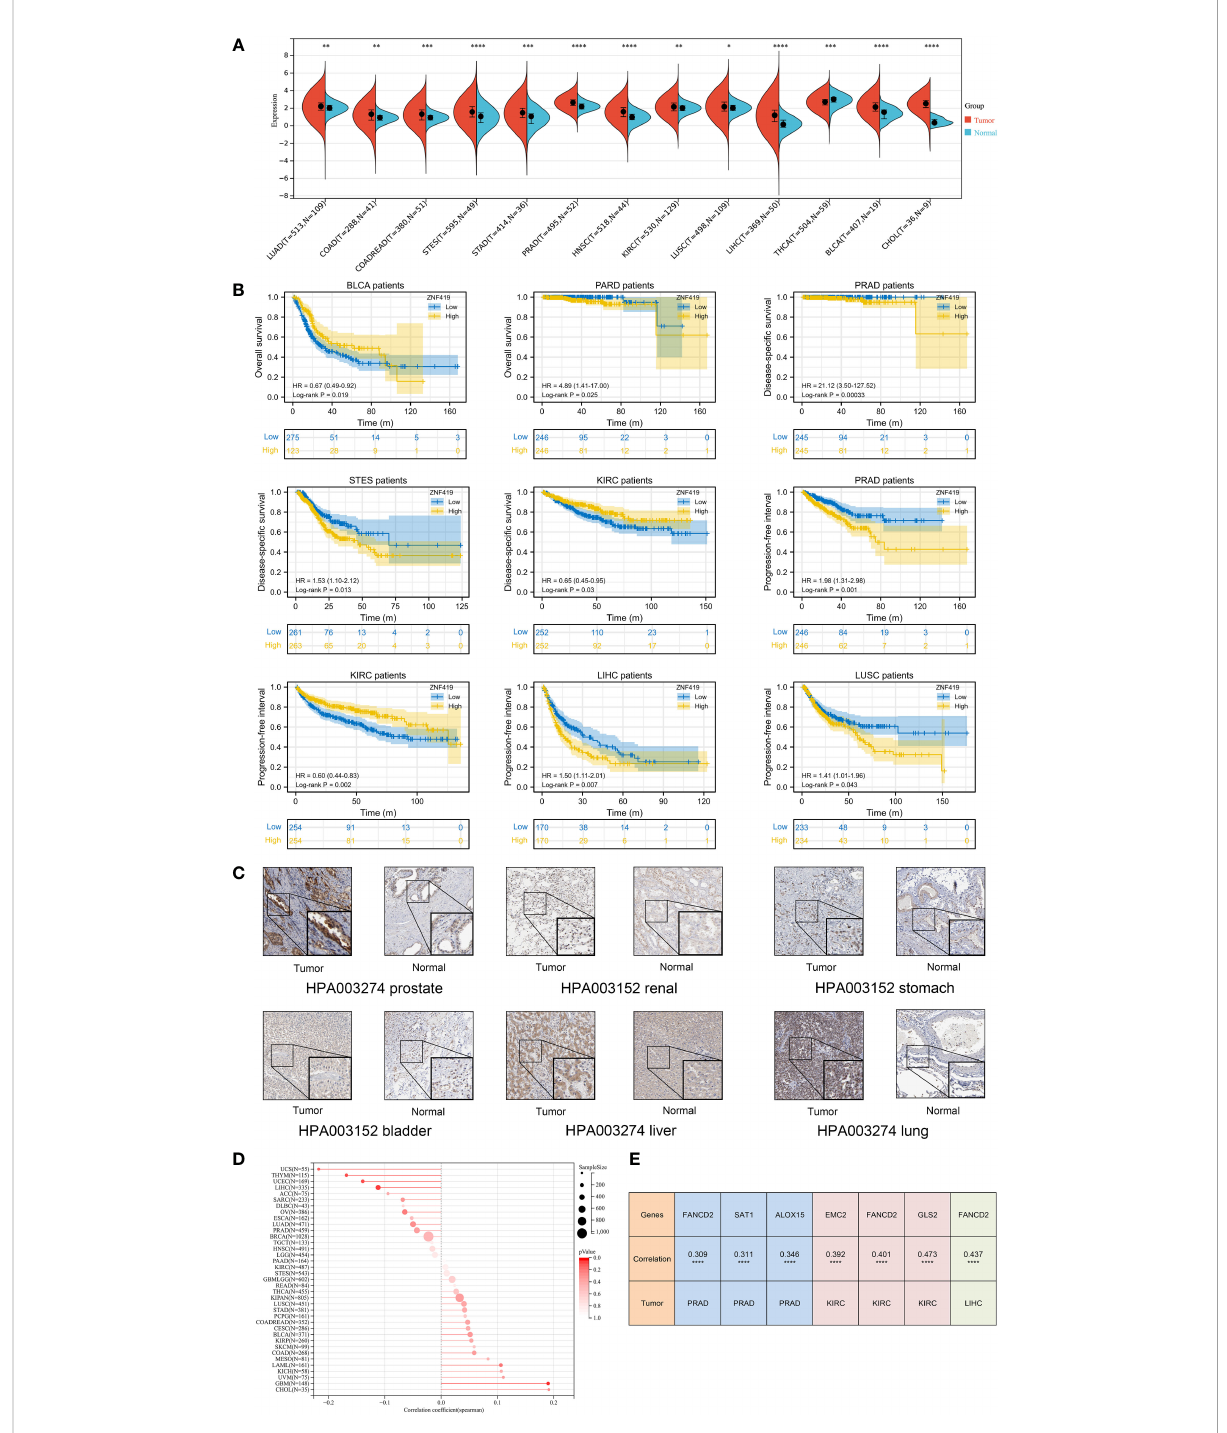
FIGURE 1 Differential expression analysis, prognosis analysis of ZNF419 in pan-cancer with validation and correlation with ferroptosis-related gene. (A) pan-cancer analysis of ZNF419 for differential expression between tumor and normal tissues; (B) prognostic analysis with survival curve for BLCA, PRAD, STES, KIRC, LIHC, and LUSC patients; (C) validation of protein expression was conducted using HPA database; (D) the correlation between patient age and ZNF419 expression; (E) correlation analysis of ZNF419 and ferroptosis-related key genes. BLCA, bladder urothelial carcinoma; PRAD, prostate adenocarcinoma; STES, stomach and esophageal carcinoma; KIRC, kidney renal clear cell carcinoma; LIHC, liver hepatocellular carcinoma; LUSC, lung squamous cell carcinoma. "*, **, ***, ****" corresponds to the p value "<0.05, <0.01, <0.001,